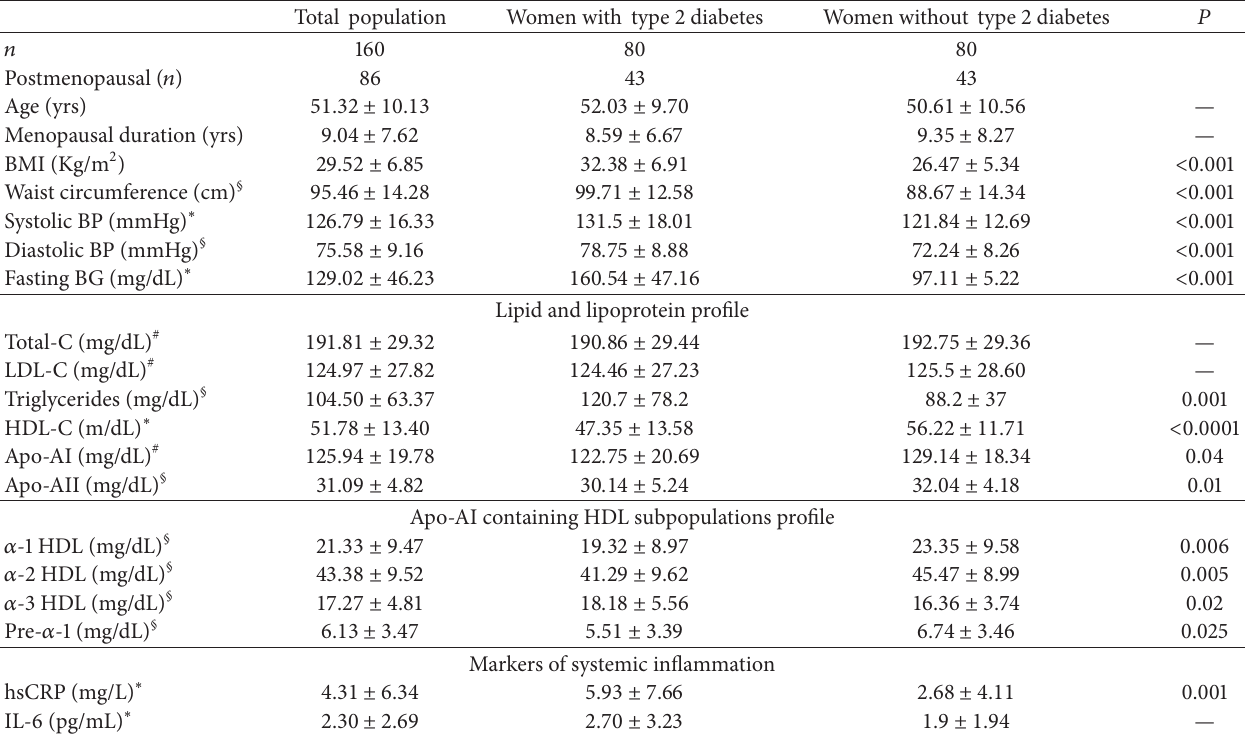
Table 1: Lipid profile, Apo-AI containing HDL subpopulations distribution, and markers of systemic inflammation in women with and without type 2